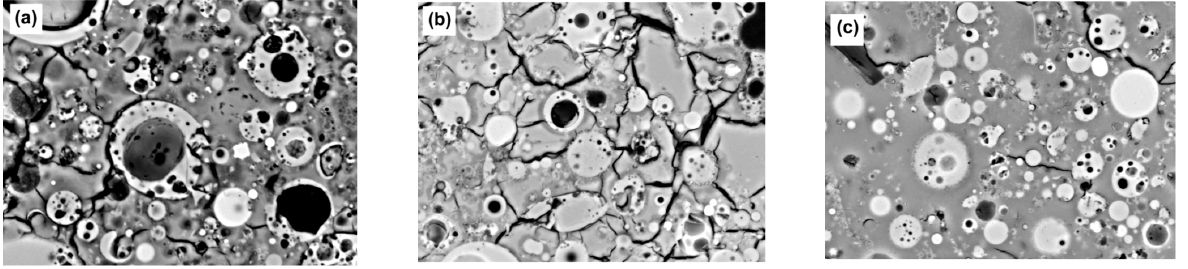
Figure 22. SEM images showing ( a ) pure GP combined with GP nanocomposites comprising 3.0 wt% nano-silica, ( b ) wet mix procedure, and ( c ) dry mix procedure. Adapted from [104].